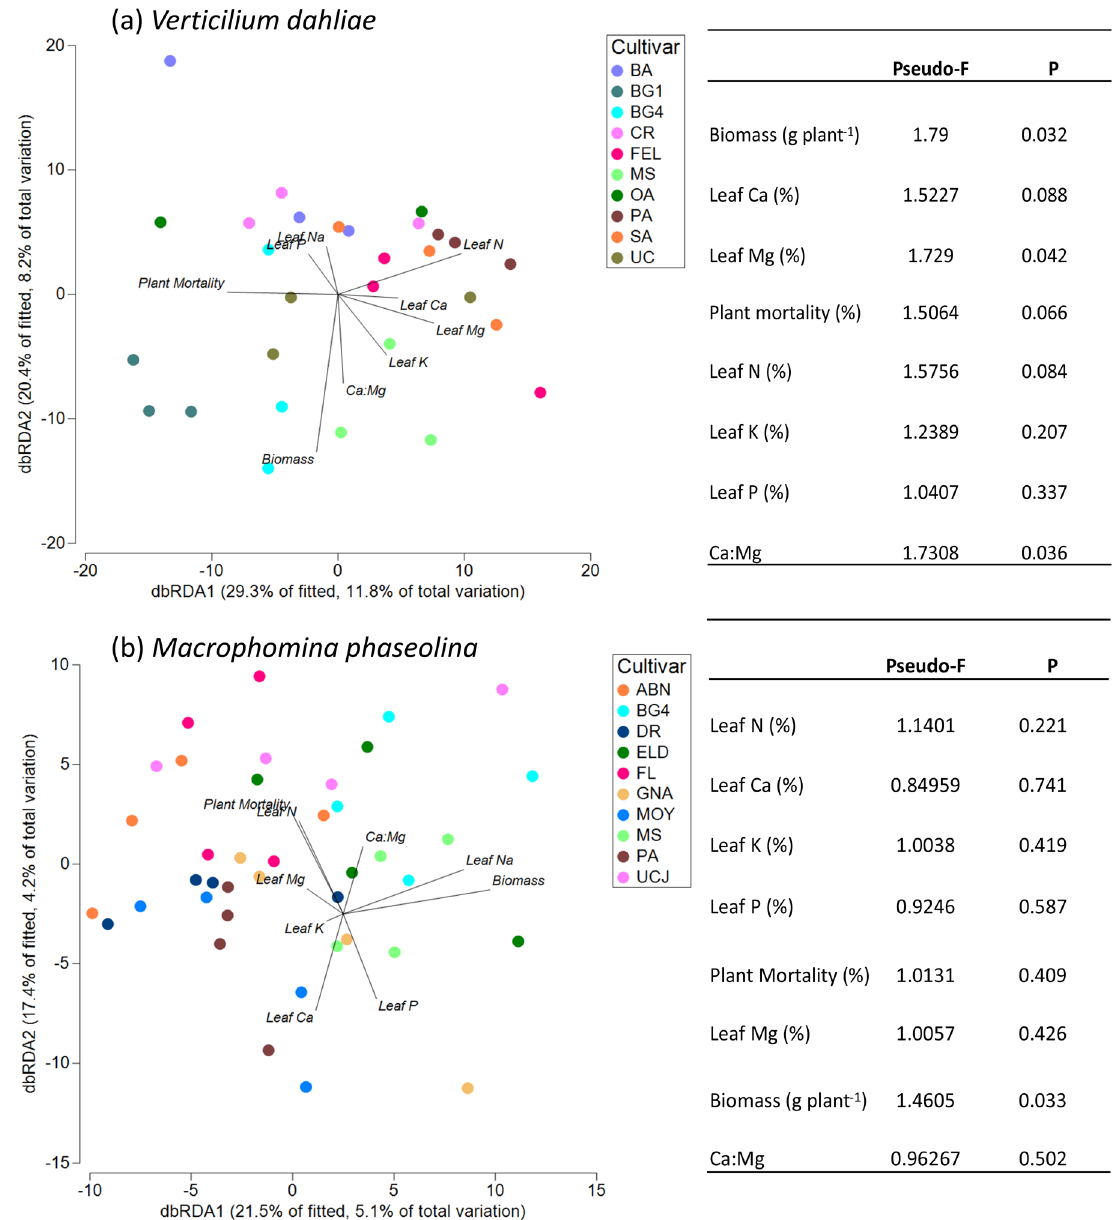
Figure 7. Distance-based redundancy analysis (dbRDA) on rhizosphere bacterial and archaeal communities at OTU level and selected plant traits in the Verticillium dahliae ( a ) and Macrophomina phaseolina ( b )